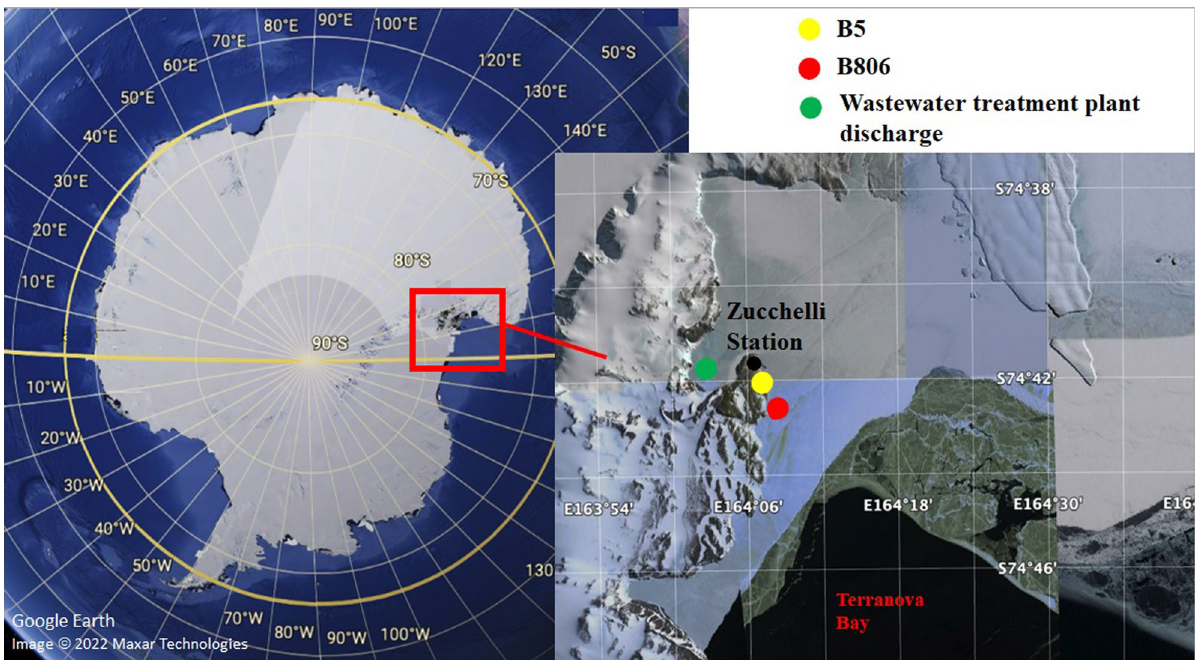
Figure 2. Study area (Terranova Bay, Ross Sea). Map was created using Google Earth (https:// earth. google. com/ web/@ 74. 69537 91,164. 09617 81,0. 41714 55a,2467. 23579 724d,30. 00002 056y,0h,0t,0r) on which sampling sites and wastewater treatment plant discharge were